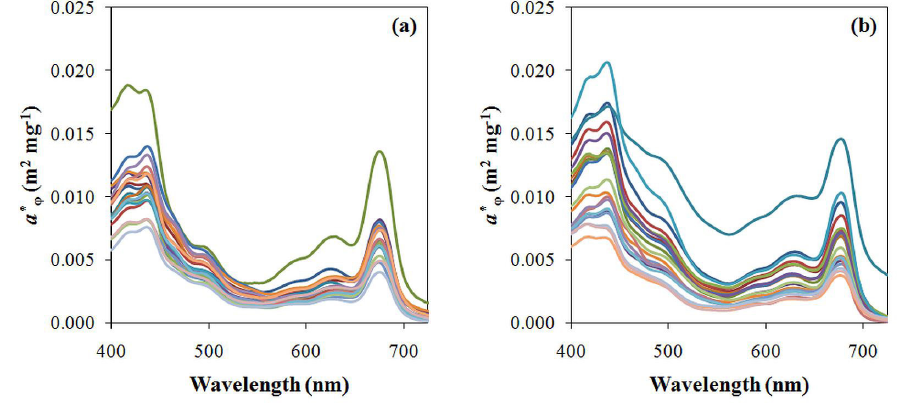
Figure 3. a * spectra measured in May (a) and October (b) φ